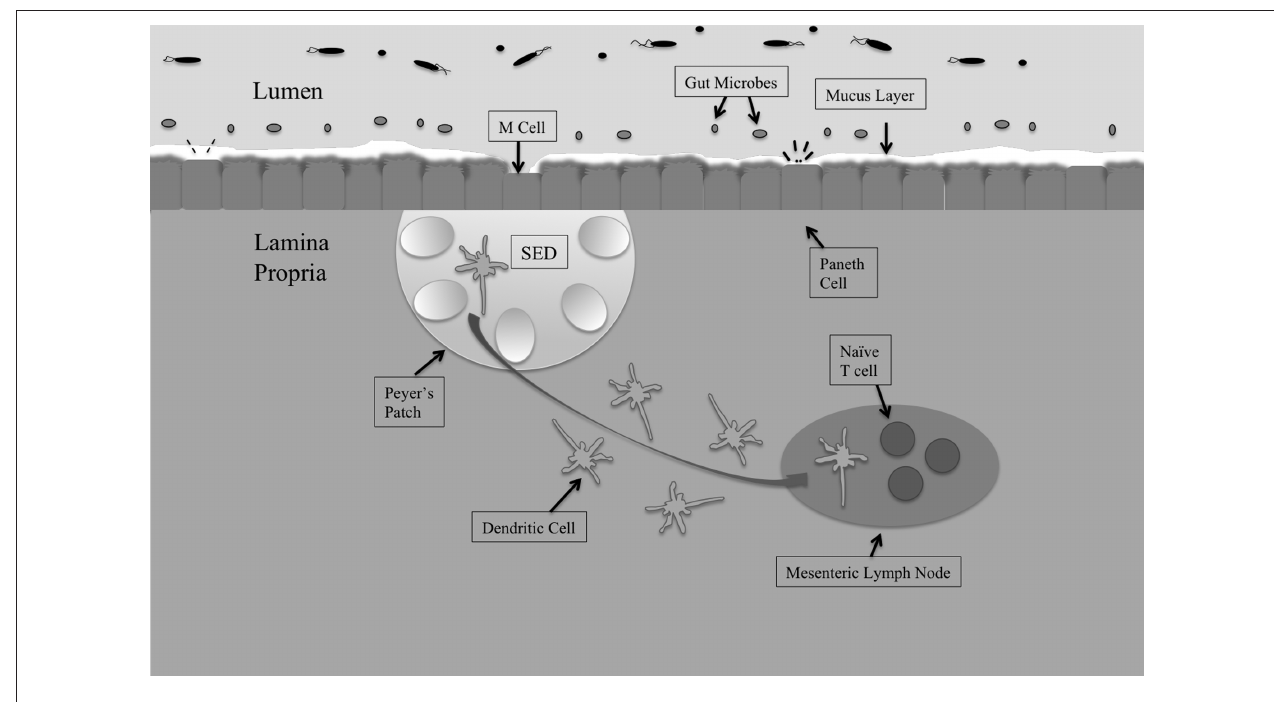
FigurE 1 | The intestinal mucosal epithelium is home to various interacting cell types that come together to maintain intestinal homeostasis and protect against invading pathogens. The first line of defense is the host microbiota, populations of commensal organisms that compete with invading pathogens for nutrients and space. The mucus layer protects against Salmonella invasion of epithelial cells, and the bacteria must adhere to mucus components in order to remain in the intestines. The